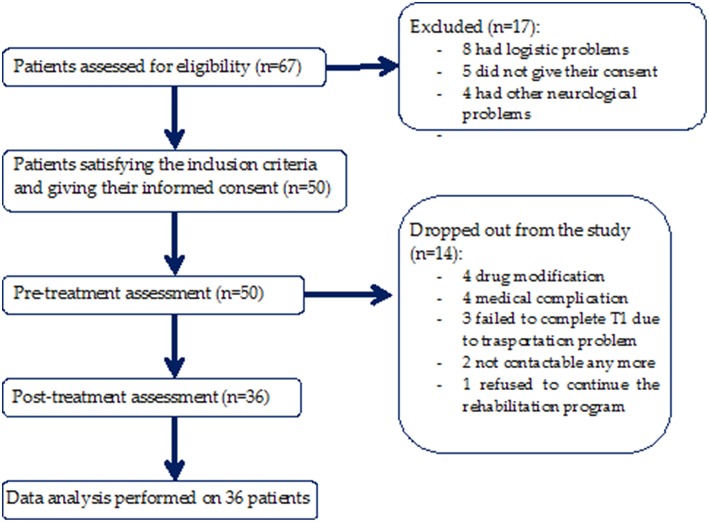
Study flow chart.